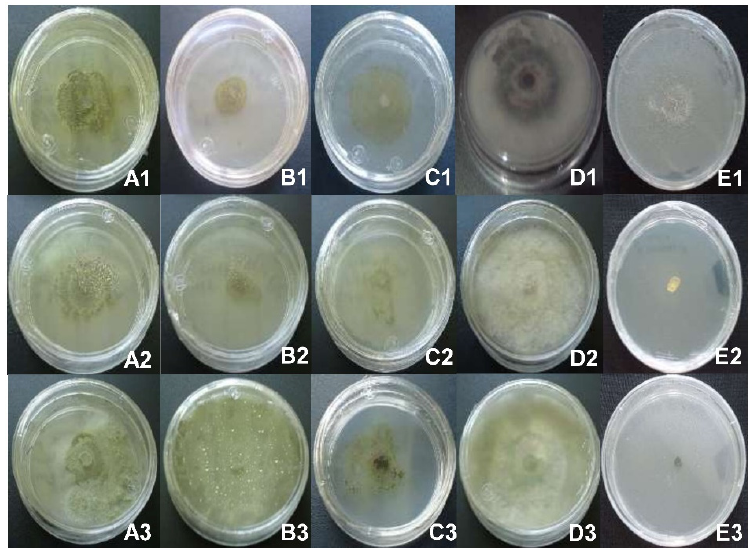
Figure 1. Inhibitory effect of the crude extracts: M5L of L. hirta ( A ), M6LFr of A. ochroleuca ( B ) and M4LS of A. porophyllum ( C ); on the mycelium of C. gloeosporioides (A1, B1 and C1), P. clavispora (A2, B2 and C2) and L. pseudotheobromae (A3, B3 and C3), at a concentration of 5 mg/mL. The negative control was absolute ethanol ( D ), and the positive control Thiabendazole ( E ). Table 1. Percentage of mycelial growth inhibition of phytopathogenic fungi of blueberry by crude extracts of L. hirta , A. ochroleuca and A. porophyllum .